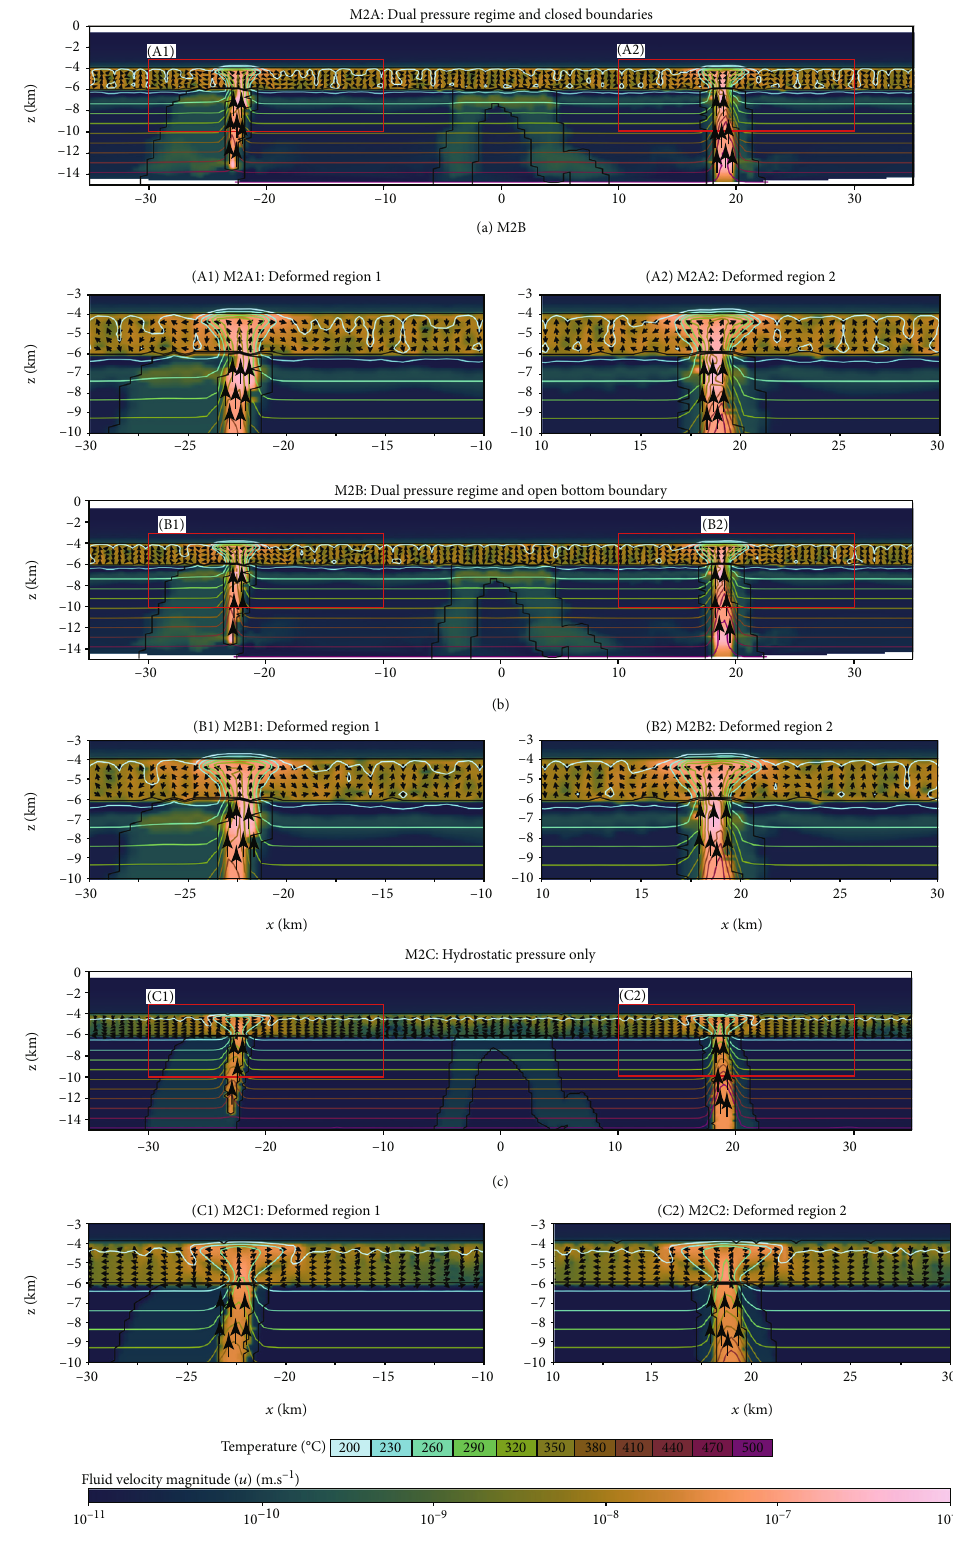
Figure 7: Thermal and fl uid fl ow results for M2 and their variations: (a) M2A in the simpli fi ed dual-pressure regime, (b) M2B with the simpli fi ed dual-pressure regime but with an open bottom boundary, and (c) M2C in a hydrostatic pressure regime. Fluid fl ow vectors shown are normalised. Permeability setup for the model can be referred to Figure 3. Isotherms are represented by solid coloured lines and are in increments of 30 ° C. Colour fi ll of the plots and isotherms is based on scienti fi c colour maps